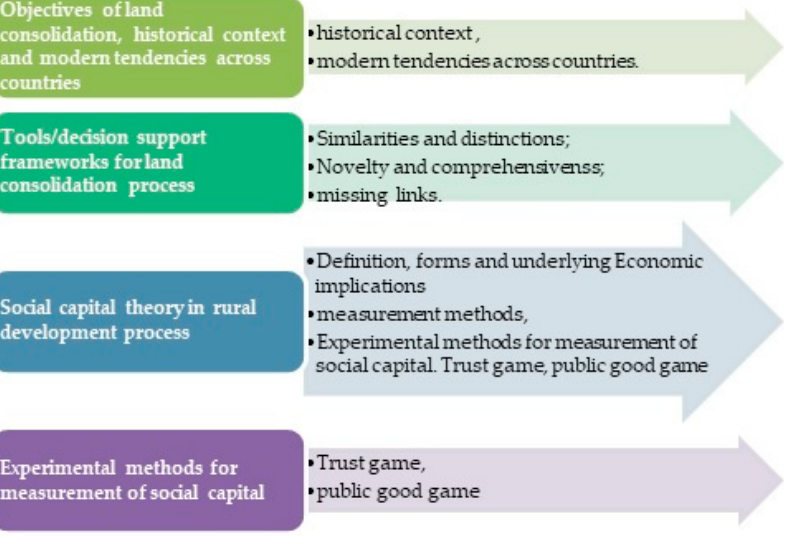
Figure 1. Description of the data collection process.